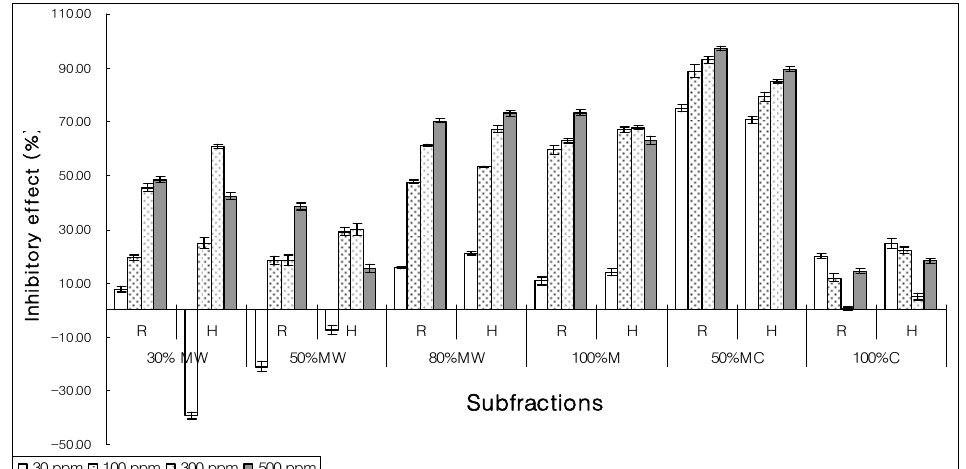
Figure 5. Allelopathic effect of different subfractions of bioactive 5%, 10% and 20% on the growth of root (R) and hypocotyls (H) of lettuce seeds after MeOH-CHCl 3 preparative reverse phase solid-phase extraction. (MC – methanol in chloroform; MW – methanol in water; M – methanol; C –